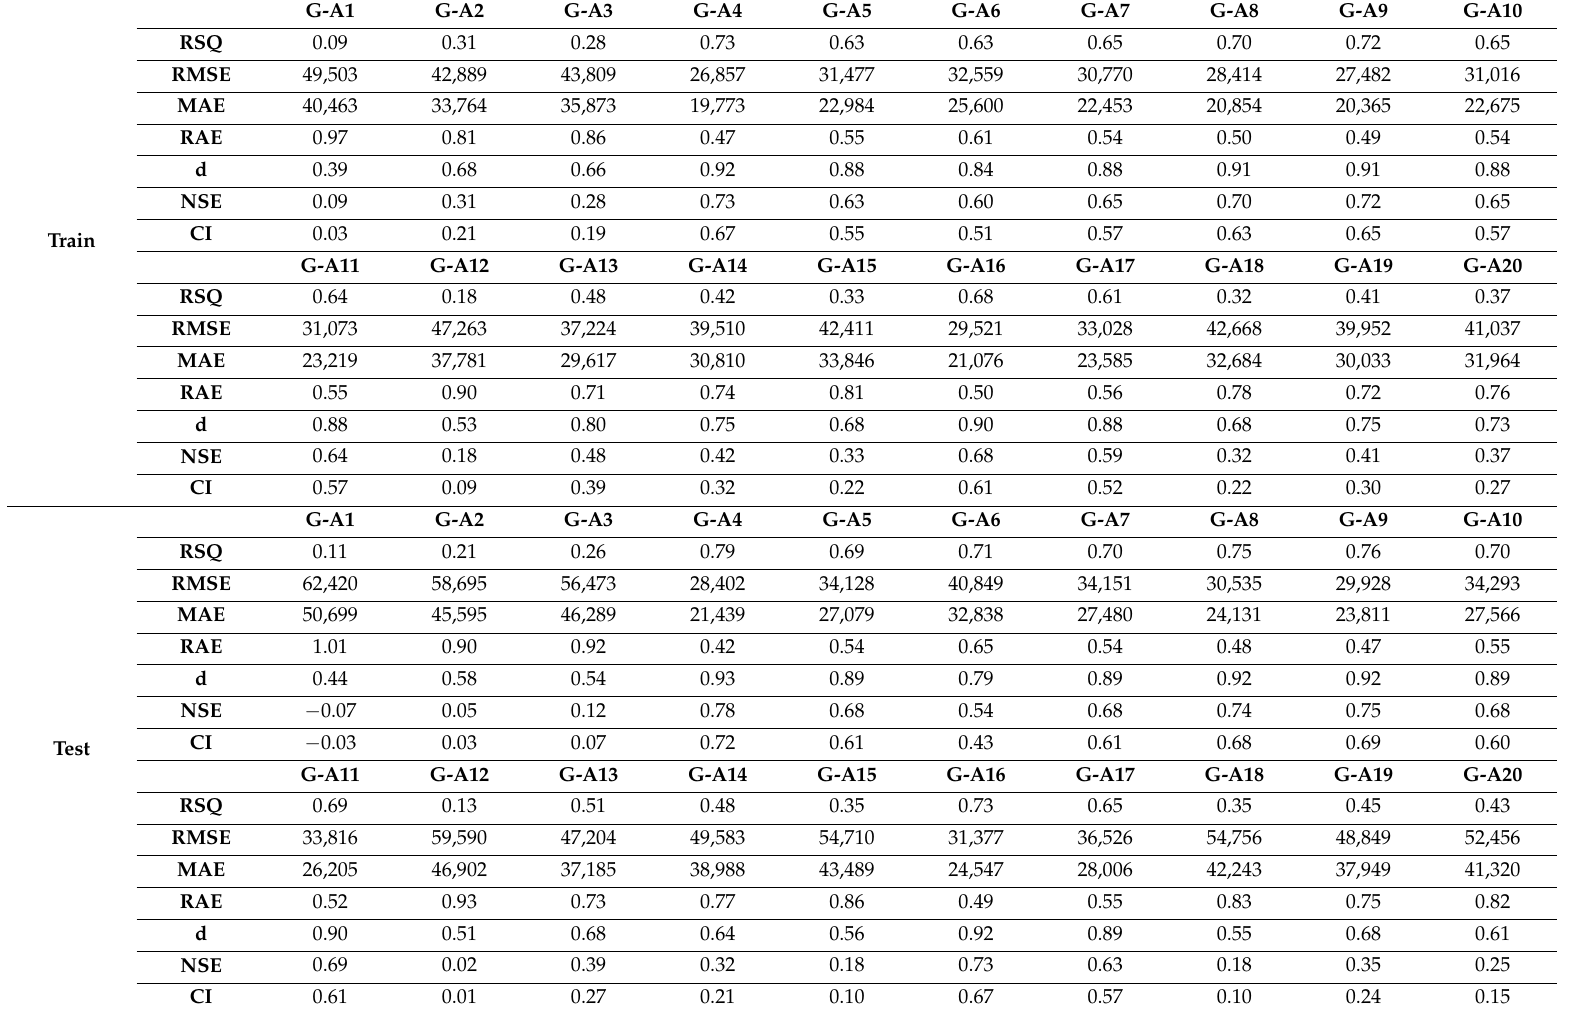
Table 5. Results of GWO-ANFIS modeling in train and test phases. G-A is the abbreviation of